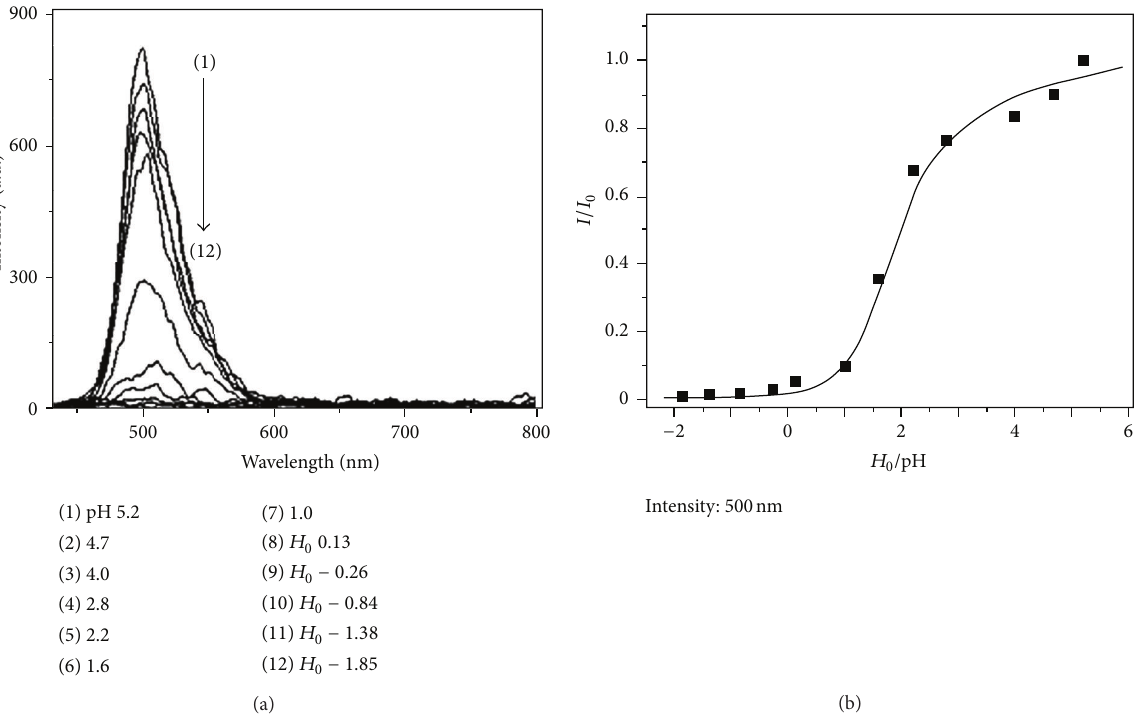
Figure 11: (a) Fluorescence spectra of C334 at various pH in C-HPA. (b) 𝐼/𝐼 0 versus 𝐻 0 /pH plot of C334 in